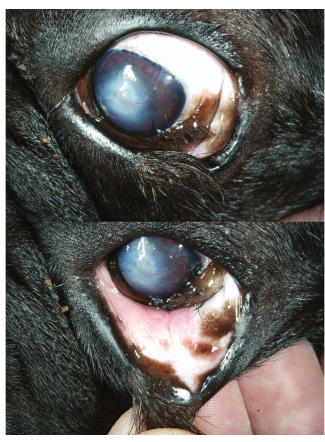
Figure 4: Case 2 appearance at initial presentation. Disorganized skintissueispresentonboththelowereyelidandtheinferotemporal region of the bulbar conjunctiva. Gentle traction on the lower eyelid reveals that the lesions are distinct and that the conjunctival aspect of the eyelid is not